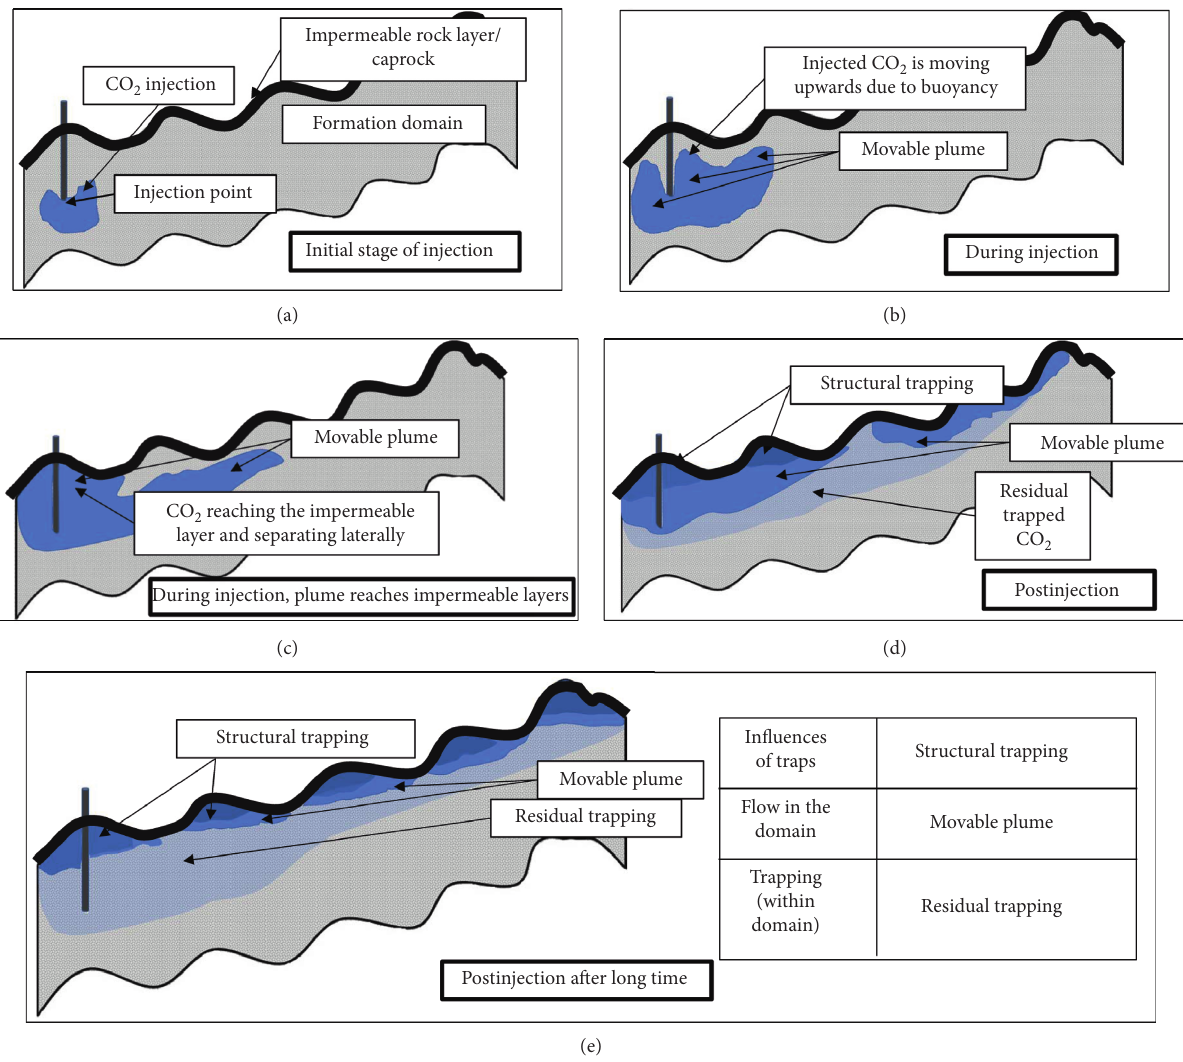
Figure 1: Classification of the structural trapping and residual trapping mechanisms during geological sequestration: (a–e) the fate of CO during injection and after injection in the geological